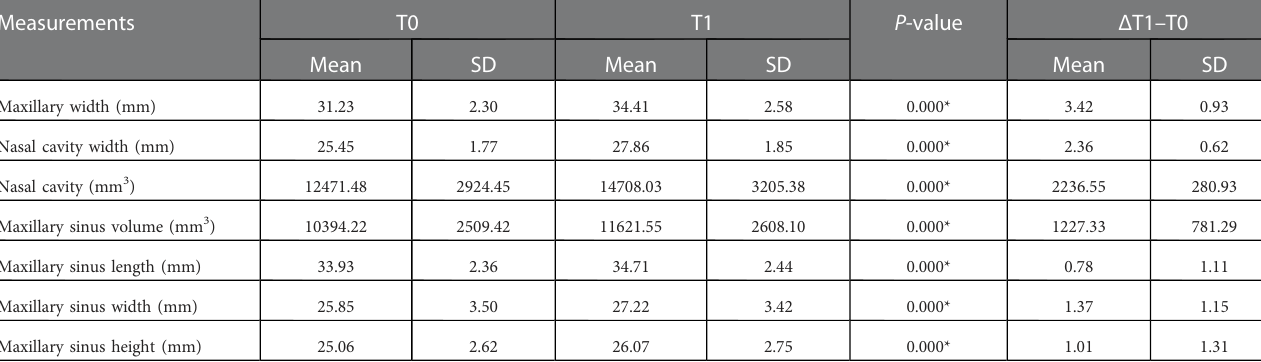
TABLE 2 Comparison of the maxillary width, nasal cavity, and maxillary sinus changes between T0 and T1.